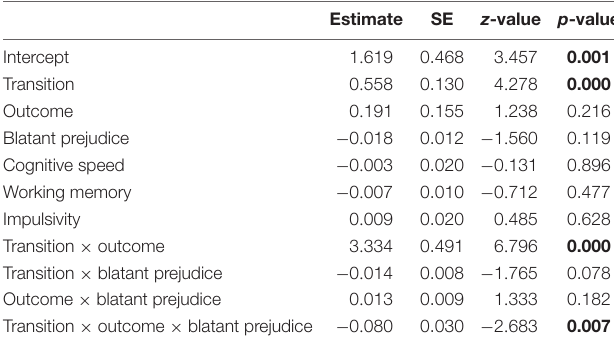
TABLE 3 | Result of the full regression analysis, indicating that blatant prejudice covaries with model-based